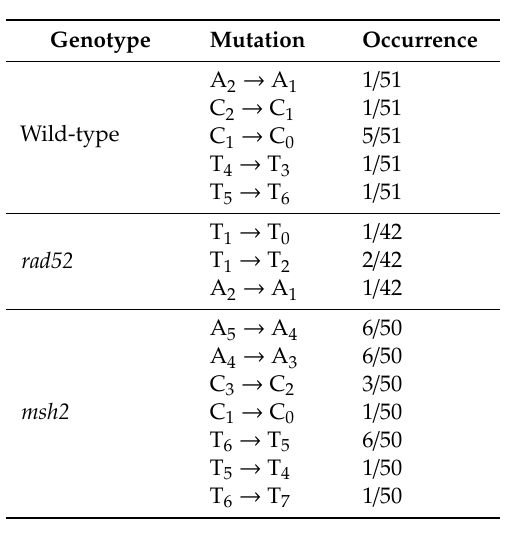
Table 2. Spectrum of deletion and insertion mutations in ura3 mutants of wild-type and msh2 caused by carbon ion beam